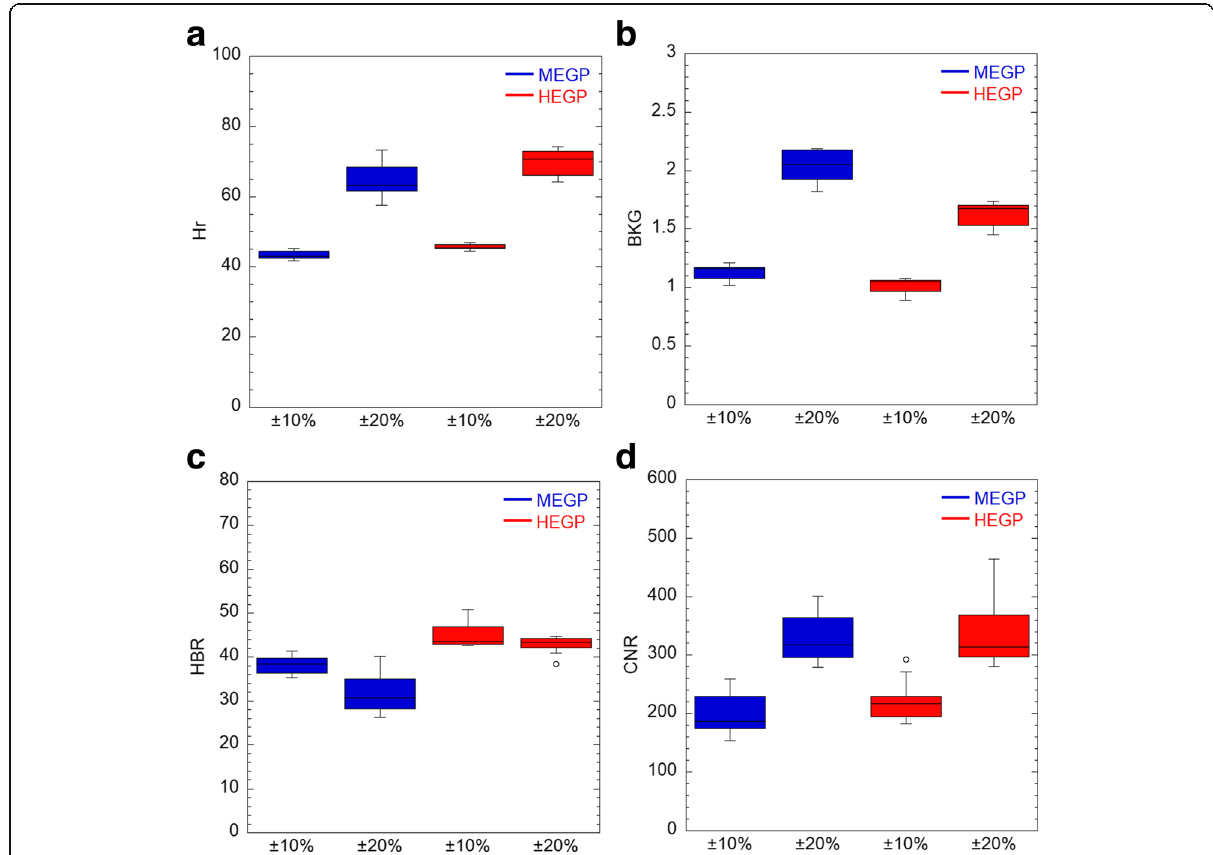
Fig. 3 a – d Comparison of SPECT image quality of the cylindrical phantom between the energy window settings of 84 keV ± 20% and 84 keV ± 10%. SPECT counts in hot rod (Hr) and background (BKG), and the standard deviation of BKG (SD) were measured. CNR and HBR are defined in the text. MEGP medium-energy general purpose, HEGP high-energy general purpose, CNR contrast-to-noise ratio, HBR hot rod-to-background